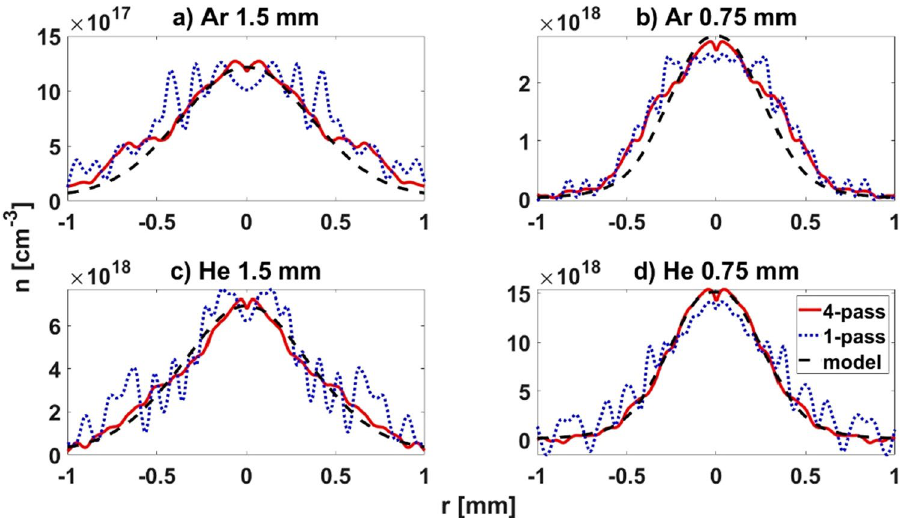
Figure 3. Comparison of density profiles calculated using the inverse Abel transform of an axisymmetric gas jet with backing pressure of 1.6 bar Ar ( a , b ) and 7 bar He ( c , d ) at 1.5 mm ( a , c ) and 0.75 mm ( b , d ) above the nozzle exit. The profiles for single-pass (dotted blue lines) and four-pass (solid red lines) probing configuration calculated from the phase maps shown in Fig. 2 are compared to the profiles from the hydrodynamic simulations (dashed black